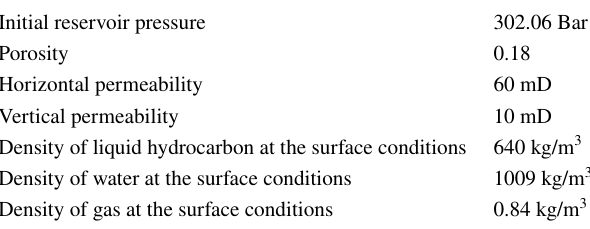
Table 3 Characteristics of the reference wet gas